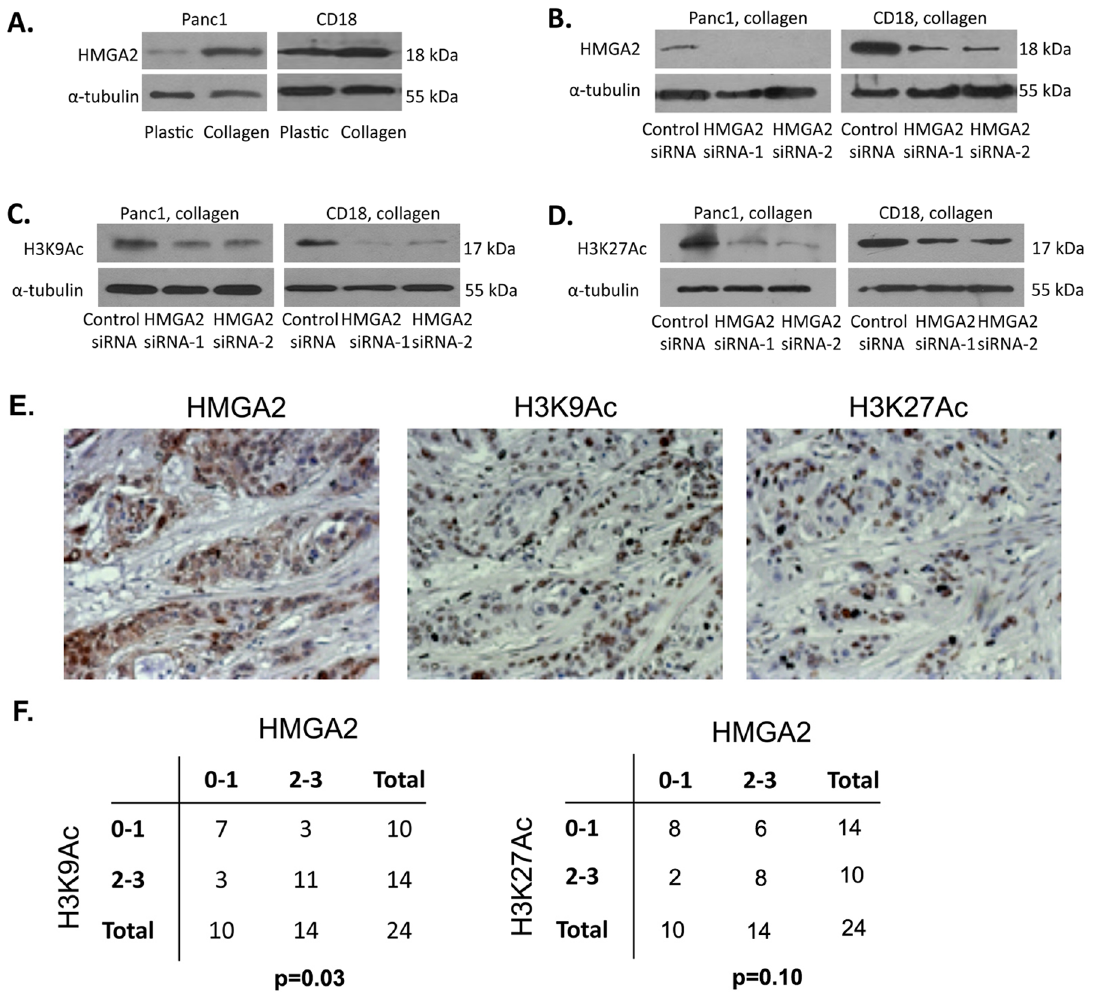
Figure 2. HMGA2 regulates collagen-induced H3K9 and H3K27 acetylation. A . Panc1 and CD18 cells were grown on tissue culture plastic or in three-dimensional collagen gels for 24 hours and immunoblotted for HMGA2. The results are representative of three independent experiments. B – D . Panc1 and CD18 cells were transfected with control siRNA or with 2 different HMGA2 siRNAs, allowed to recover overnight and then embedded in three-dimensional collagen for 24 hours. Lysates were then immunoblotted for HMGA2 ( B ), histone H3K9Ac ( C ) and histone H3K27Ac ( D ) using a - tubulin as loading control. The results are representative of at least three independent experiments. E . Human pancreatic TMAs were immunostained for HMGA2 ( left ), histone H3K9Ac ( middle ) and histone H3K27Ac ( right ). F . The relationship between HMGA2 and histone H3K9Ac or H3K27Ac was assessed by Fisher’s exact test.